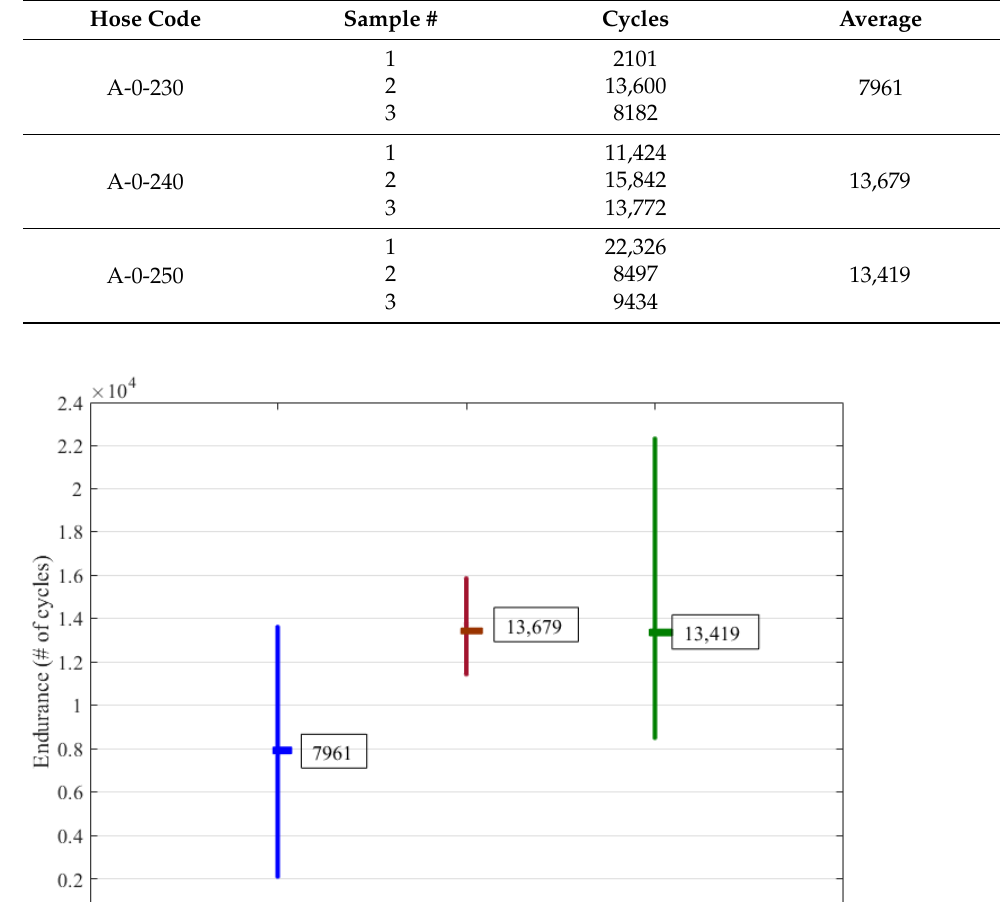
Table 4. Average of the number of cycles of each hose in sample set 1 performed until failure.